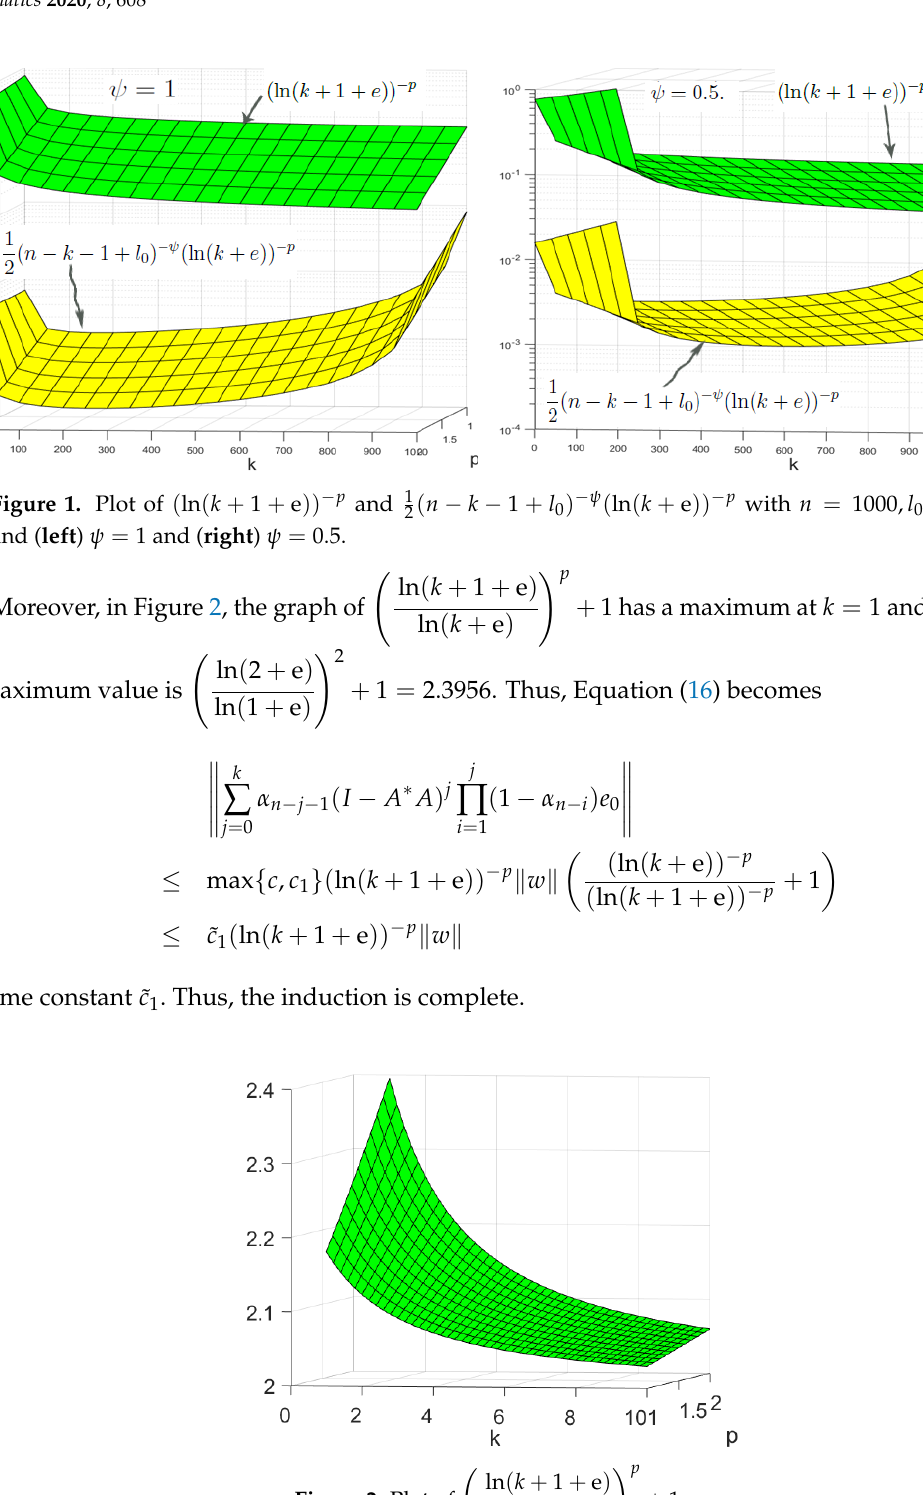
Figure 2. Plot of